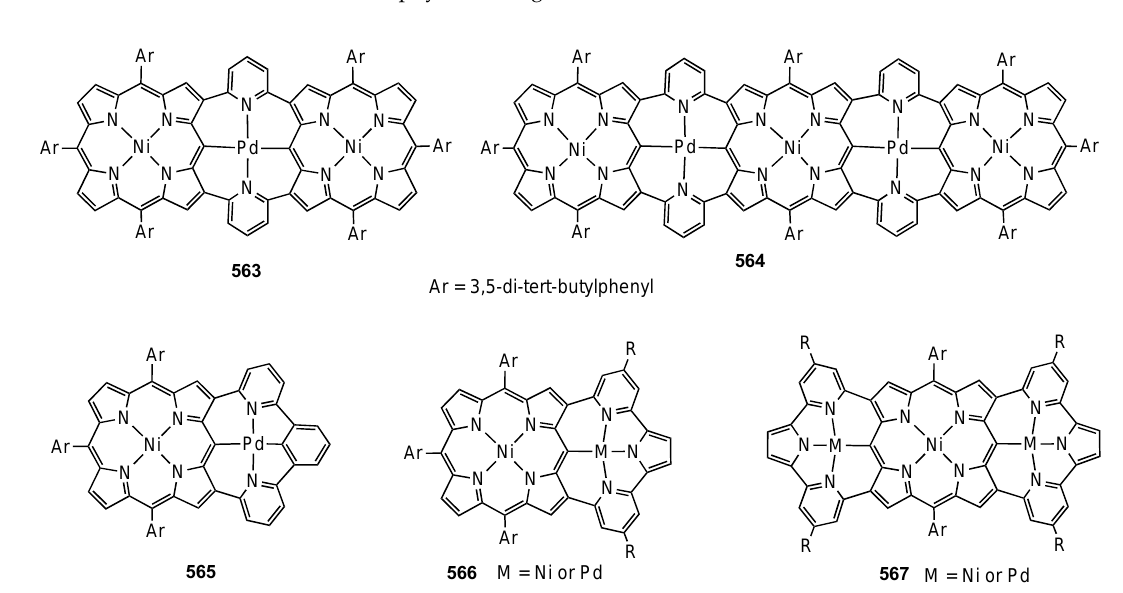
Figure 16. Metal complexes of porphyrins with appended carbaporphyrin-like loops.